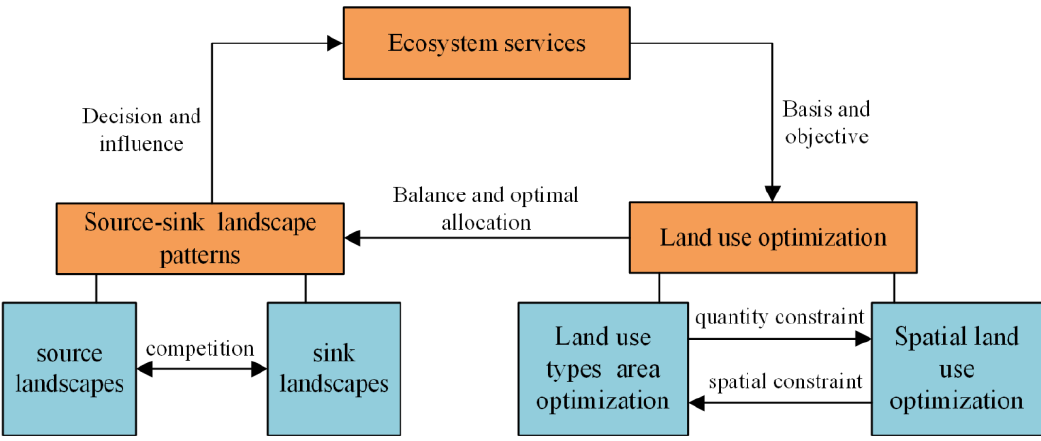
Figure 3. Relationship between land use optimization and the source-sink landscape patterns associated with ESs.